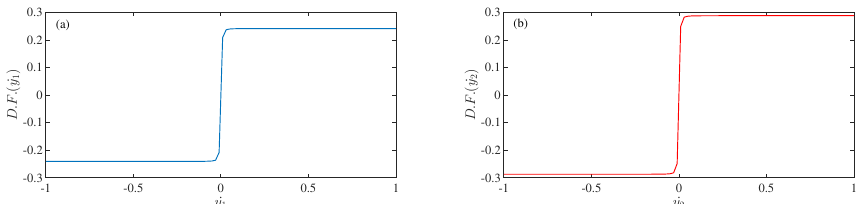
Figure 2. Evolution of the Dry-Friction terms with varying the ( a ) state-variable ˙ y 1 of the first oscillator and ( b ) state-variable ˙ y 2 of the second oscillator, respectively. In each figure, the x -axis is the non-dimensional velocities (i.e., state-variables ˙ y 1 and ˙ y 2 ) and the y -axis is the non-dimensional dry-friction terms. The parameter values are: a 1 = 5.8548 × 10 − 3 , ( a ) ζ 1 = 0.0868, ( b ) ζ 2 = 0.1036. (Color online).